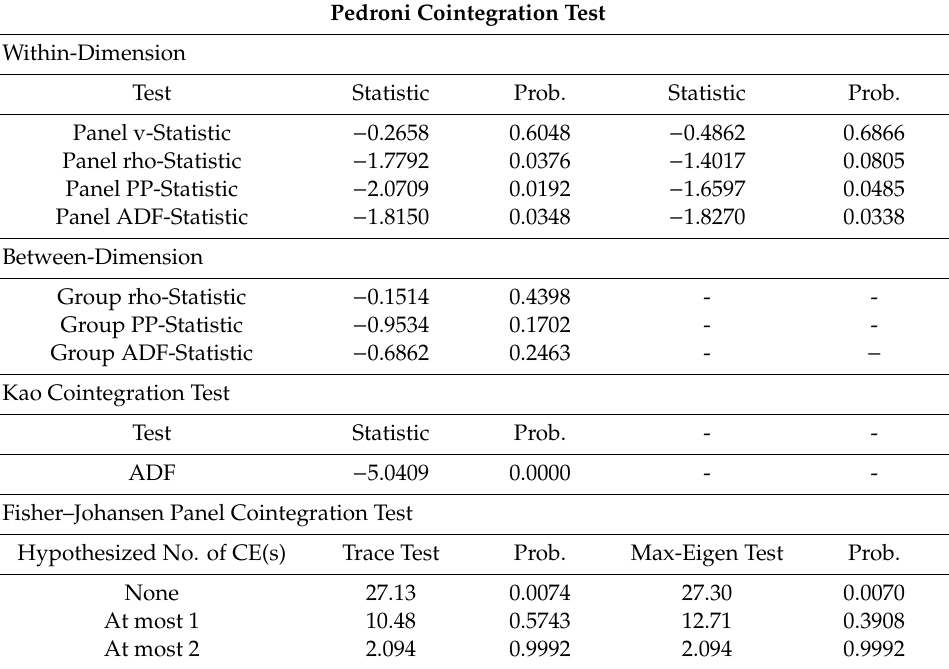
Table 5. Panel cointegration tests.